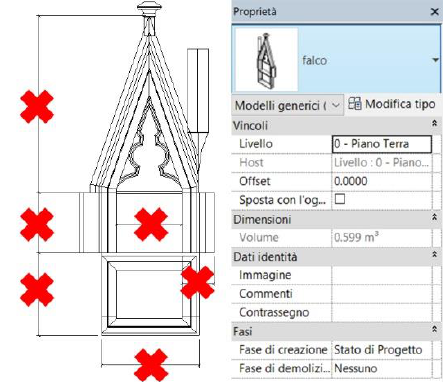
Figure 8. The model in Revit has no meshes and it is not possible to attribute variable bonds for parametrization, but it is possible to add information.